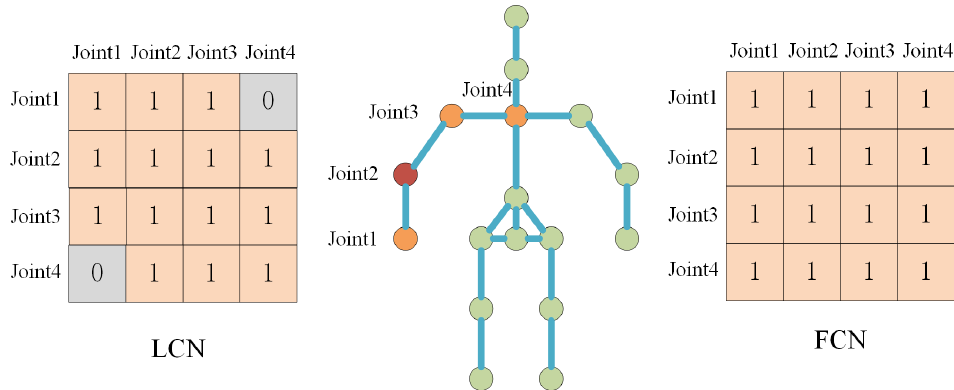
Figure 3. The difference of structure matrix between LCN and GCN. For Joint2, the LCN considers only the relationships within the orange joints, while the FCN considers the relationships with all other